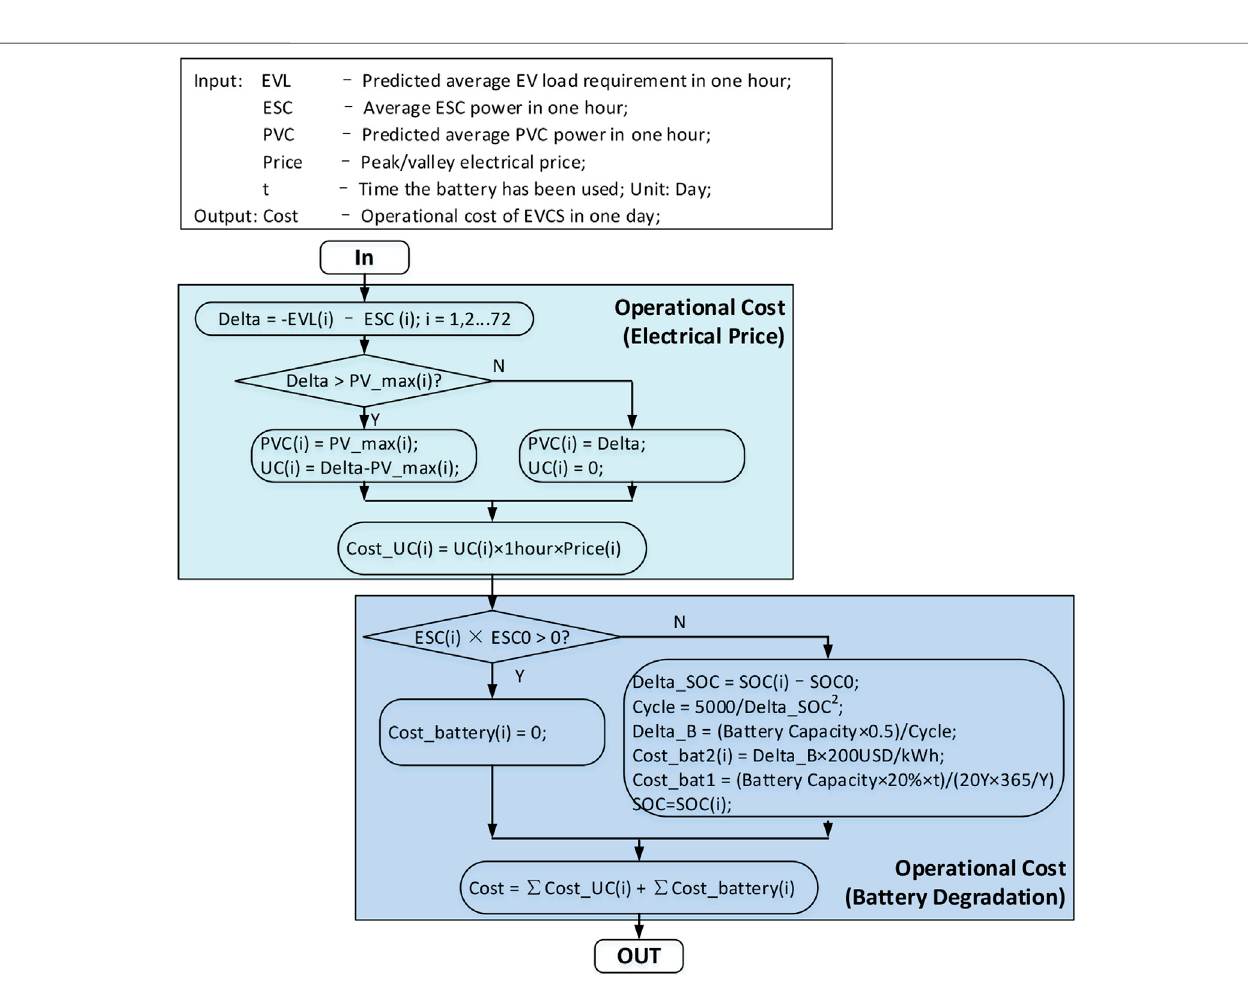
Frontiers in Energy Research |